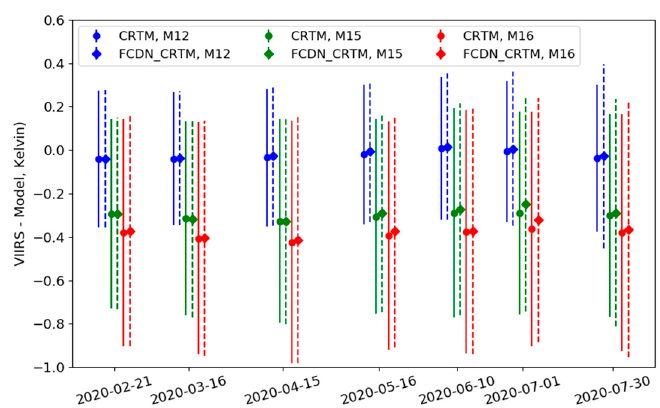
Figure 9. Same as Figure 8, but for VIIRS observations minus model (CRTM or FCDN_CRTM)) in M12, M15, and M16.